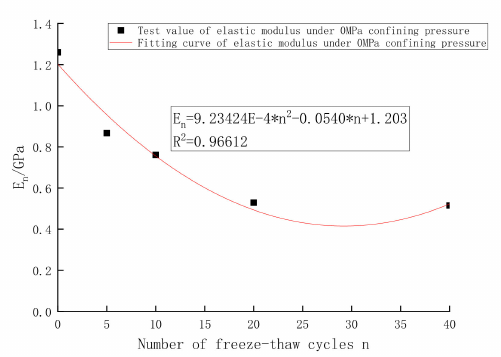
Figure 3. Fitting curve of elastic modulus under different freeze-thaw cycles under confining pressure of 0 MPa.